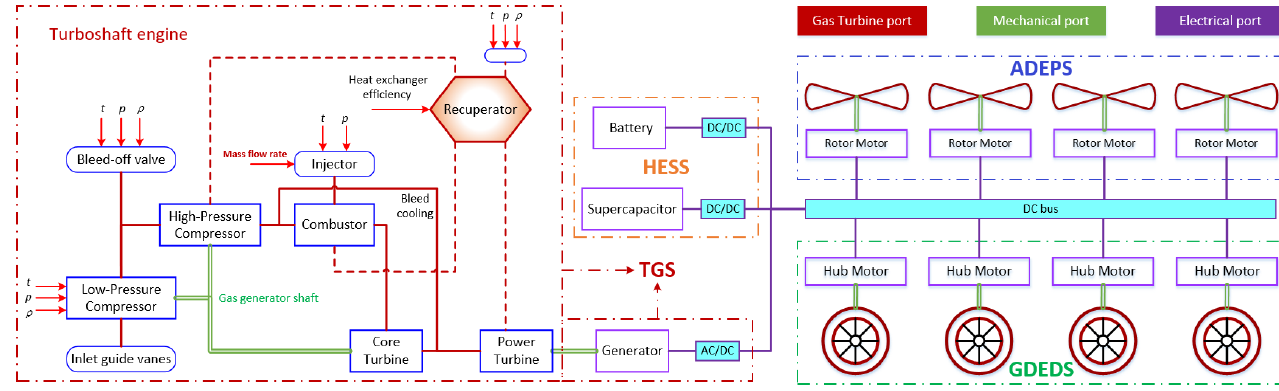
Figure 2. Powertrain architecture of turbo-electric hybrid propulsion system in HAGA. Table 1. Basic parameters of hybrid air–ground